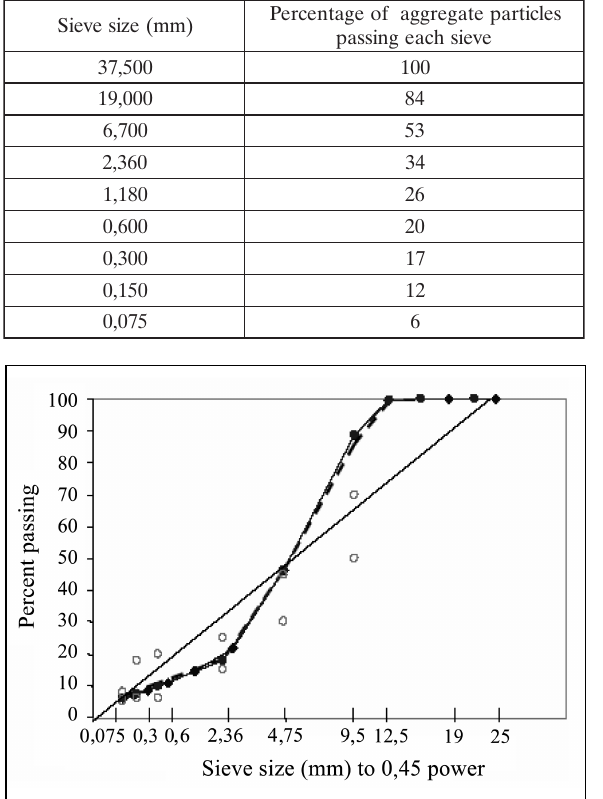
Table 1. Aggregate gradations for all test series